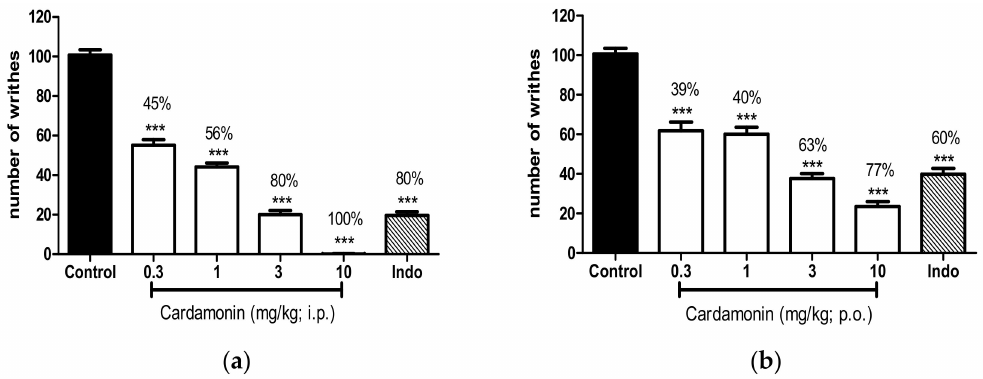
Figure 1. ( a ) Effect of cardamonin (0.3, 1, 3, 10 mg/kg, i.p.) administered intraperitoneally against acetic acid-induced nociception. ( b ) Effect of cardamonin (0.3, 1, 3, 10 mg/kg, i.p.) administered orally